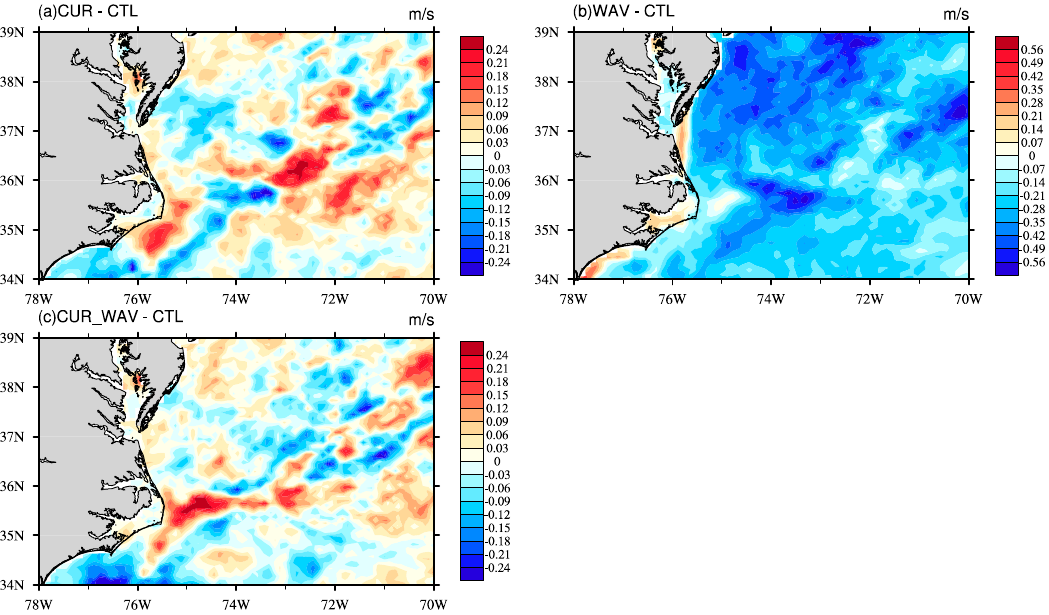
Figure 12. The 30 day averaged 10-m wind (color shaded, m/s) differences between ( a ) CUR and CTL, ( b ) WAV and CTL, and ( c ) CUR_WAV and CTL.